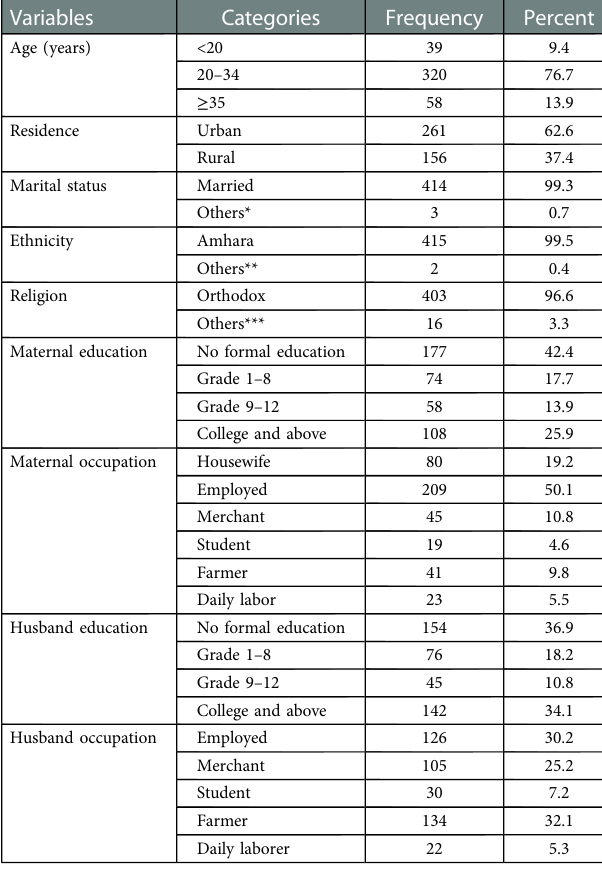
TABLE 1 Sociodemographic characteristics of mothers who gave birth in South Gondar zone hospitals, Northwest Ethiopia,